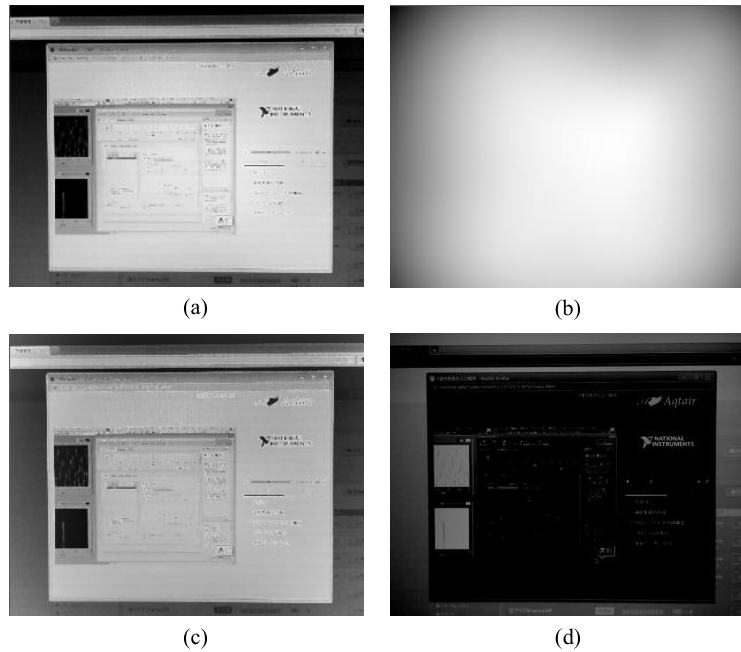
Fig. 3. Image enhancement results: (a) input image, (b) 2D interpolated image, (c) enhanced image, (d) inversed